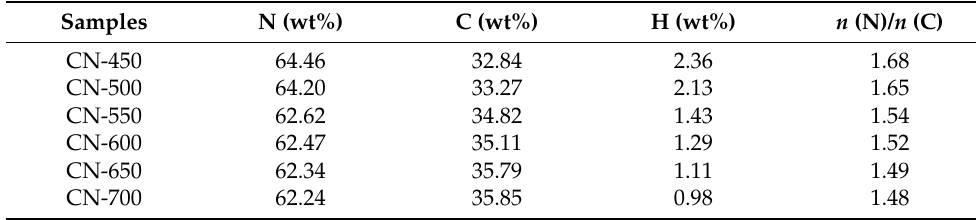
Table 2. EA results of the samples.